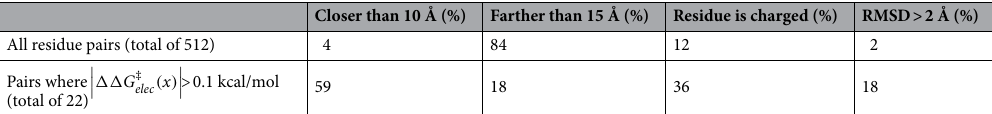
Table 4. Comparison of relative share of amino acid residues in some relevant groups in the total population of residue pairs (total of 512) vs. in pairs where (cid:31)